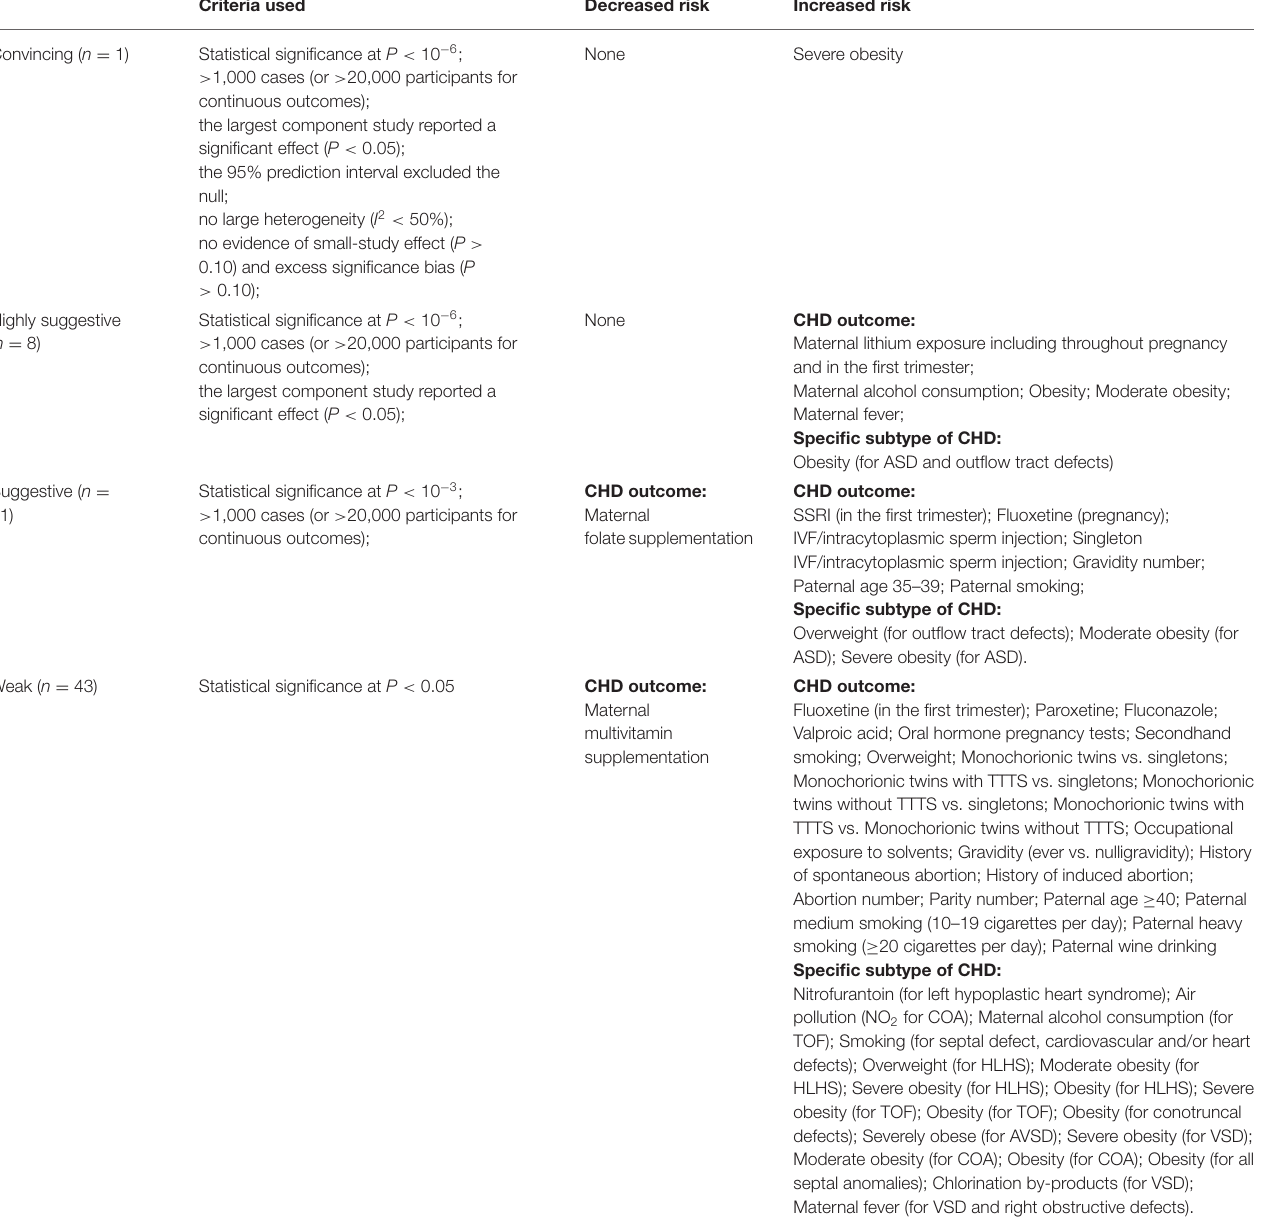
TABLE 2 | Summary of evidence grading for meta-analyses associating environmental factors and